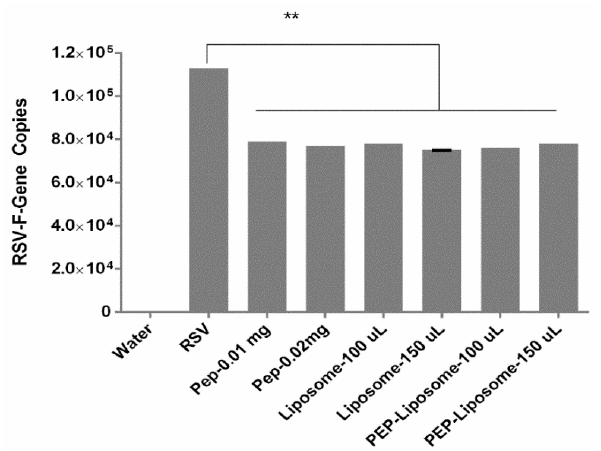
Figure 7. Screening of the RSV-F gene amplicon dilution with water as negative control. Comparison of viral gene amplicon and peptide, liposomes, and peptide-loaded liposomes. ( n = 3 ± SD). Significant difference between the samples represented as ** p < 0.01.